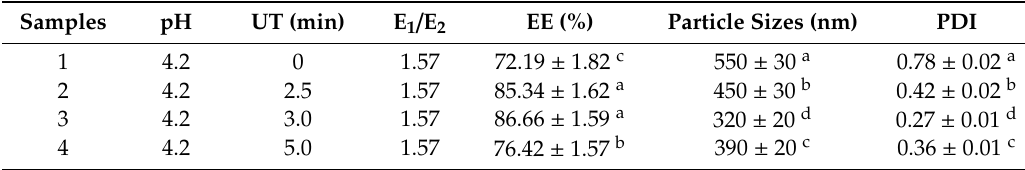
Table 2. Particle sizes, encapsulation e ffi ciency (EE), and polydispersity (PDI) values of encapsulated nisin (EN) under di ff erent ultrasound